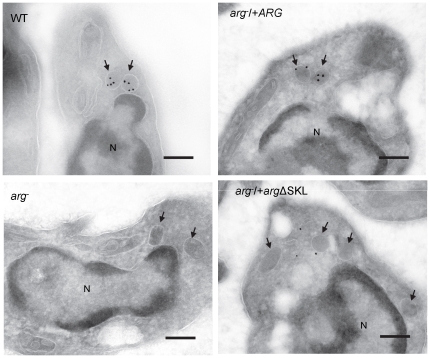
ARG cytosolic localization in arg
−/+argΔSKL add-back opposed to ARG glycosomal compartmentalization in WT and arg
−/+ARG add-back.Cytological preparations probed for ARG immunolocalization via electron microscopy of L. amazonensis wild type (WT), ARG knockout (arg
−), and the add-backs arg
−/+ARG and arg
−/+argΔSKL promastigotes. Images are representative of at least 8 different sections. Black arrows indicate membrane-surrounded organelles that present the same microscopic pattern as glycosomes. Parasite nuclei (N). Scale bar: 250 nm.